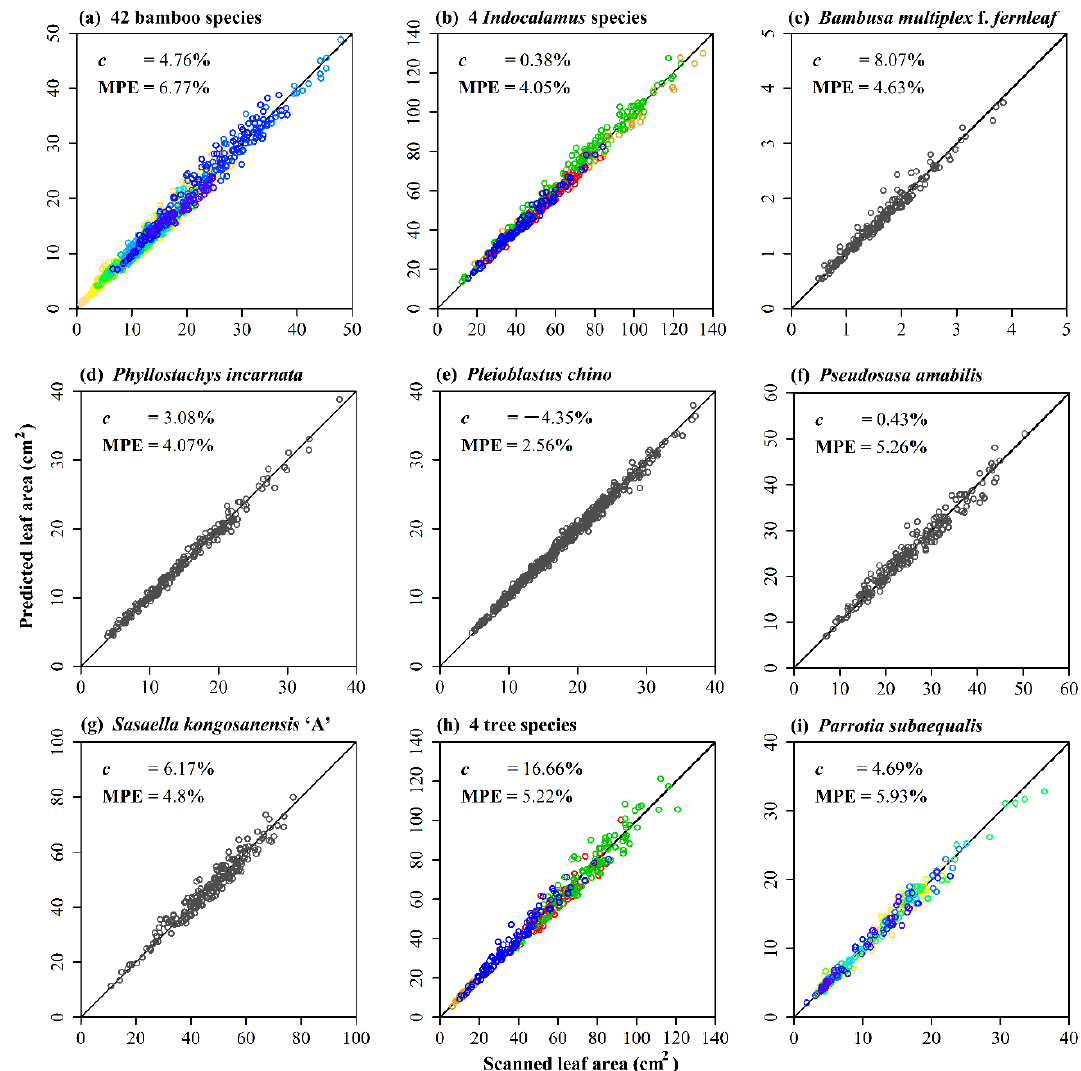
Figure 6. Comparison between the scanned leaf area and the predicted leaf area based on leaf length and leaf width with an additional parameter, i.e., the floating ratio in leaf length ( c ). Panels ( a – i ) represent the results of the comparison between the scanned and predicted leaf areas for the nine datasets (see 2.1 Materials for details), respectively. MPE denotes the mean percent error of leaf area. The solid line represents y = x , and the dashed line represents the regression line between the scanned and the predicted leaf areas. In each panel, the small open circles regardless of colors represent the planar coordinates consisting of the scanned leaf area (as the x -coordinate) and the predicted leaf area (as the y -coordinate). In panels ( a , b , h ), each color represents a species. However, the same colors in different panels do not represent the same species. In panel ( i ), different colors represent different geographical